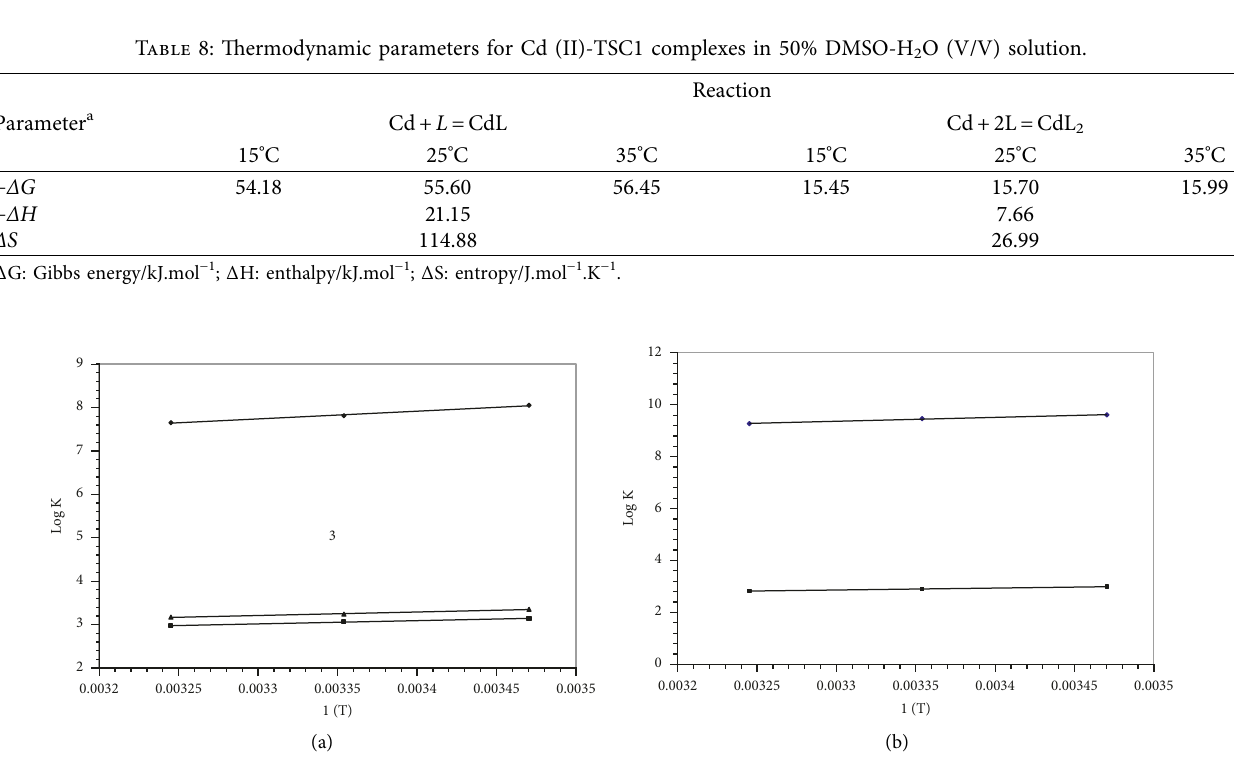
Table 7: Thermodynamic parameters for the protonation of ligand (TSC1) in 50% DMSO-H Parameter a